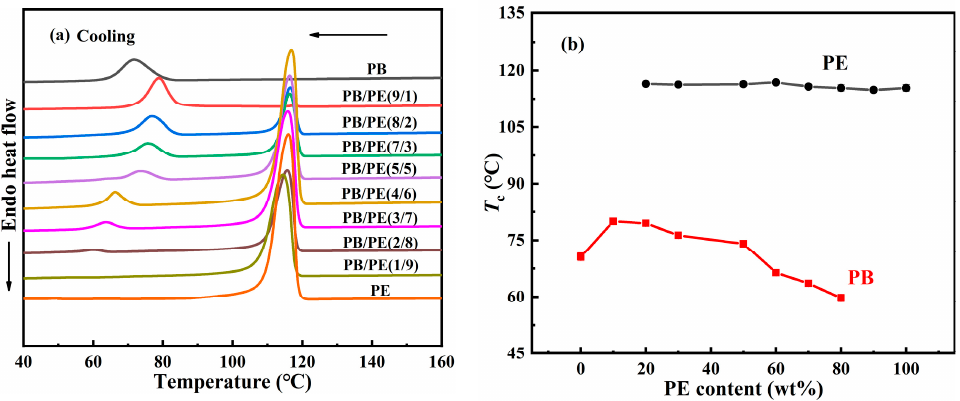
Figure 1. ( a ) DSC cooling curves of blends and pure polymers. ( b ) The cooling crystallization temperatures ( T c ) as a function of PE content.